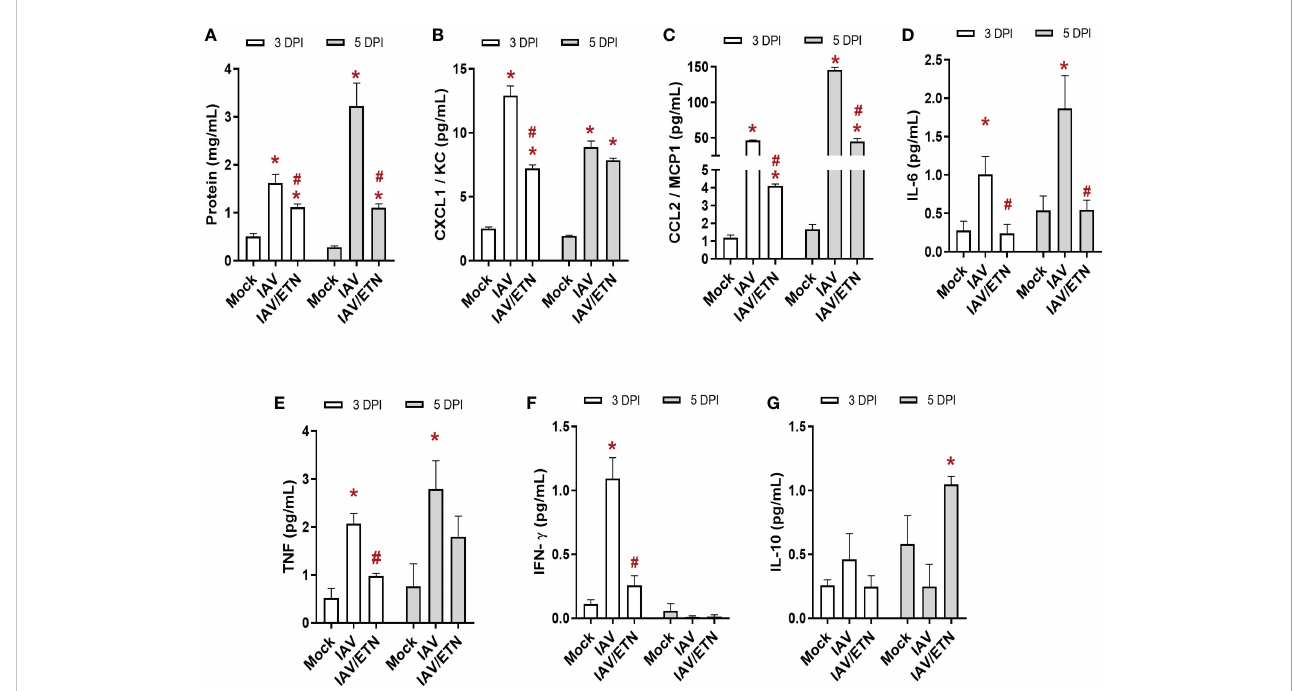
FIGURE 6 Etanercept reduced the cytokine storm in IAV-infected mice. C57Bl/6 mice were inoculated intranasally with 10 3 PFU of IAV with and without daily treatment with Etanercep (ETN, 2.5 mg/kg, i.p.). At days 3 and 5 postinfection (DPI), animals were euthanized, and bronchoalveolar lavage (BAL) was collected for quanti fi cation of total protein (A) and in fl ammatory mediators. The levels of CXCL1/KC (B) , CCL2/MCP1 (C) , IL-6 (D) , TNF (E) , INF- g (F) and IL-10 (G) were measured by ELISA. Data are expressed as the means ± SEMs; one-way ANOVA with Dunnett ’ s post hoc test. * P < 0.05 in comparison to mock and # P < 0.05 in comparison to the IAV-infected untreated group. Experiments were performed with 4-6